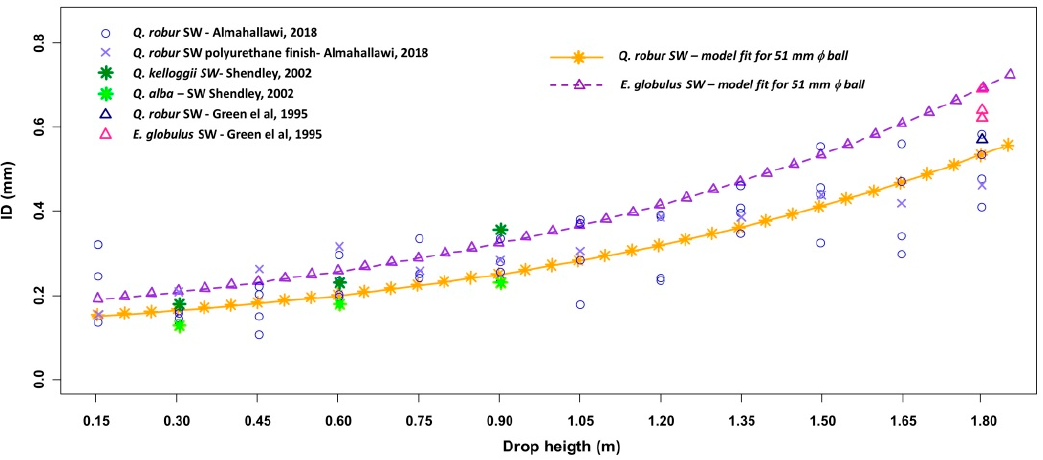
Figure 7. Comparative representation of validation model.